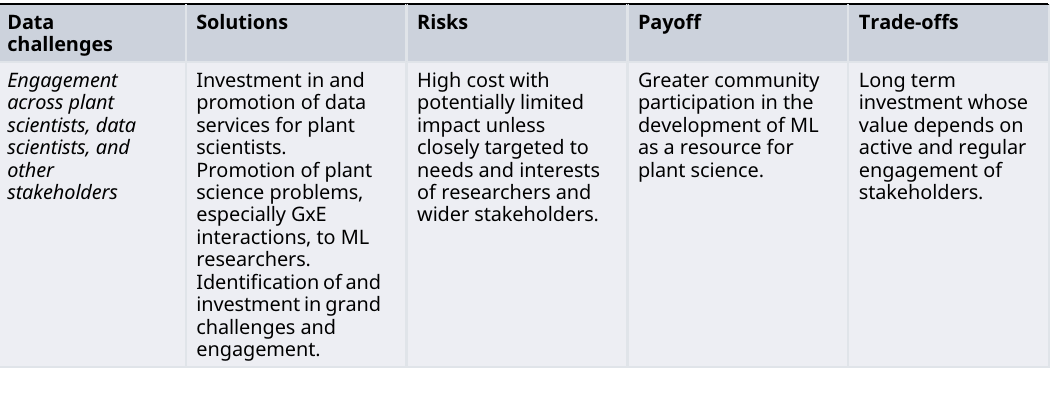
Table 2. Examples of machine learning and artificial intelligence applications in plant and agricultural science discussed in this paper and methods used in those papers. Example Section Key ML/AI methods discussed